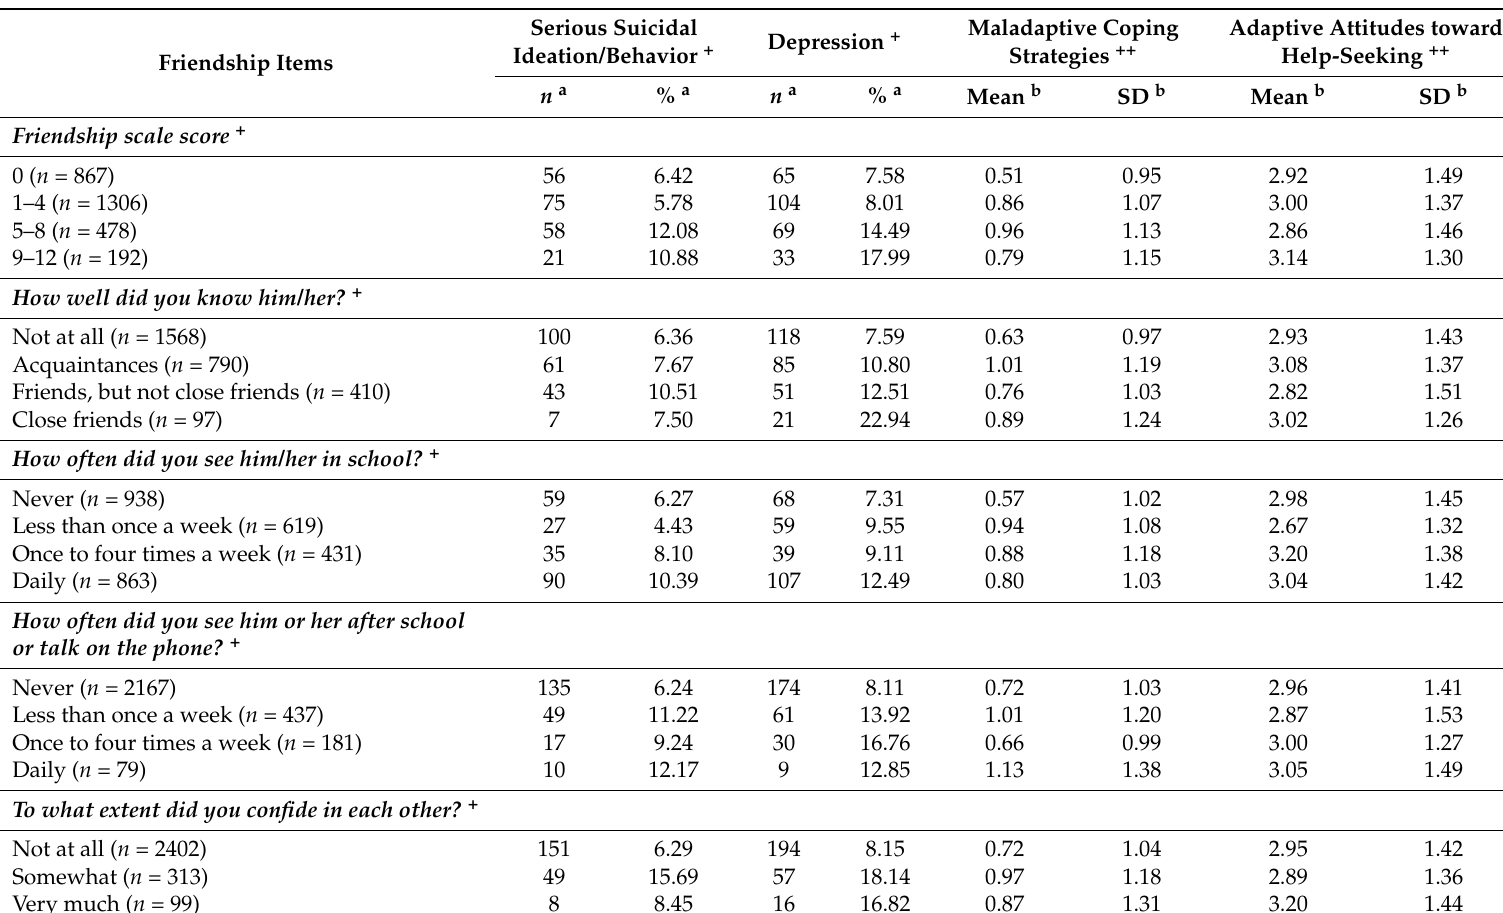
Maladaptive Coping Adaptive Attitudes toward Serious Suicidal Depression + Strategies ++ Help-Seeking Ideation/Behavior +